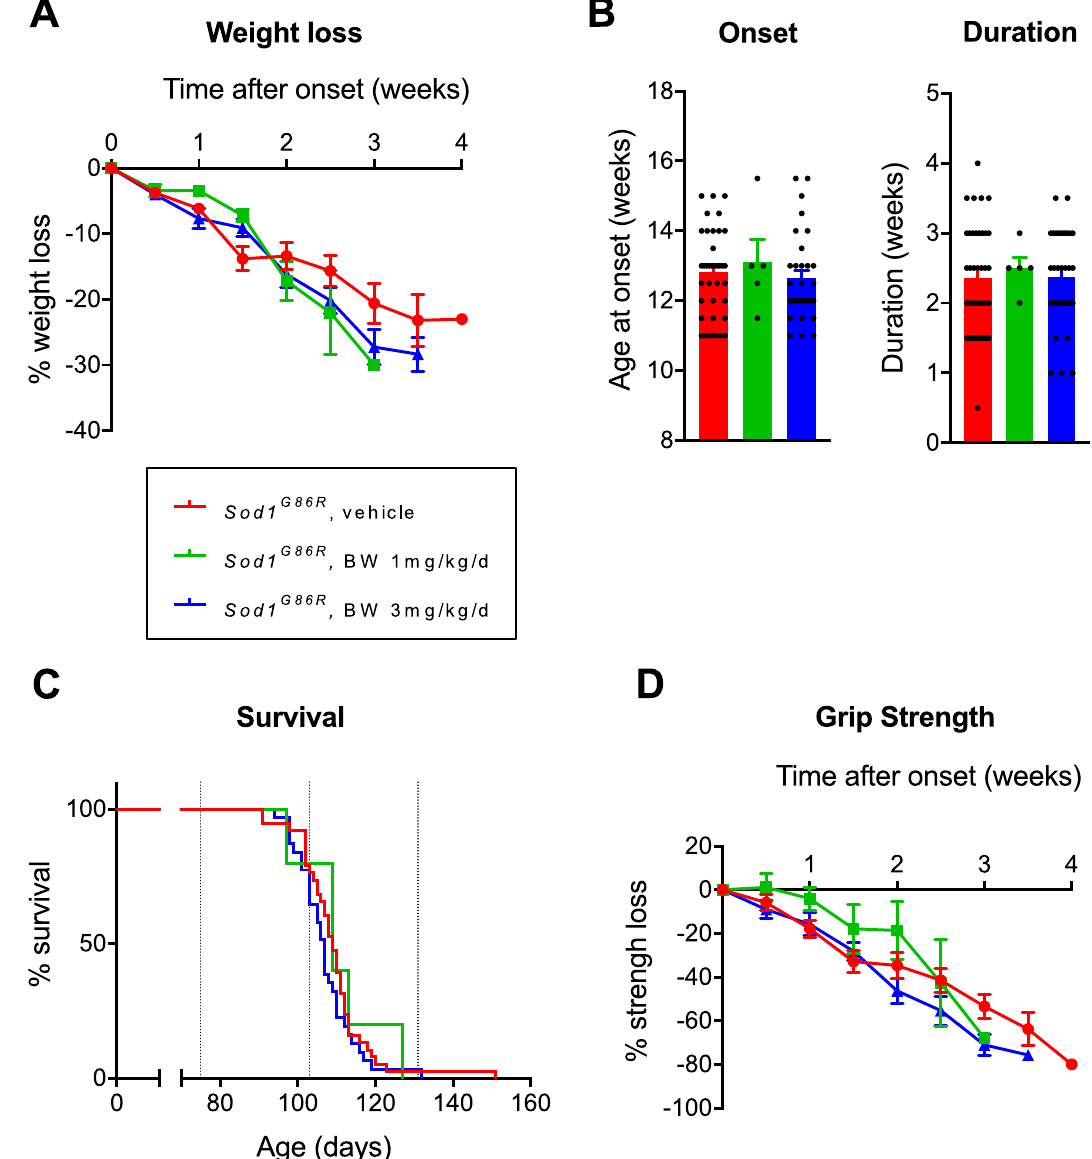
Figure 2. BW neither modifies survival nor motor function in Sod1 G86R mice. ( A ) Loss of body weight represented as percentage of loss after onset. Represented as mean +/− SEM. ( B ) Mice age at onset, defined as the peak of body weight and disease duration calculated as time between onset and death. Represented as mean +/− SEM. ( C ) Kaplan–Meier curve of survival. ( D ) Loss of muscular strength represented as percentage of loss after onset. Represented as mean +/− SEM. Groups are displayed as follow : Sod1 G86R in red (N = 38), Sod1 G86R treated with BW at 1 mg/kg/d in green (N = 5) and Sod1 G86R treated with BW at 3 mg/kg/d in blue (N =